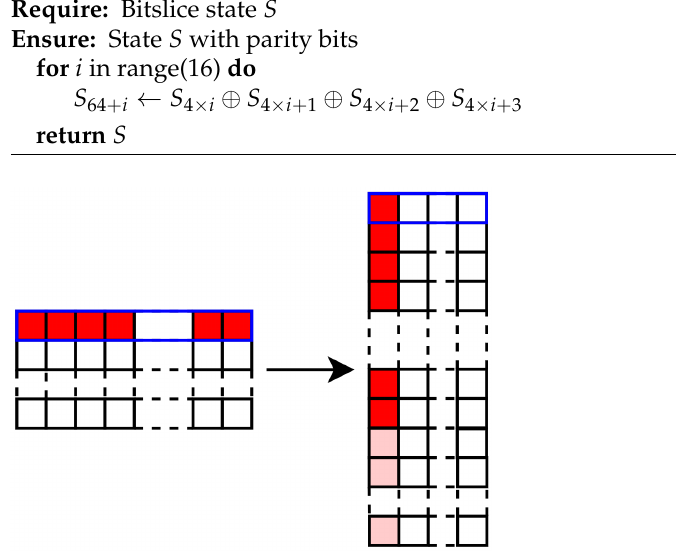
Algorithm 5 Parity bits added to the bitslice state S .